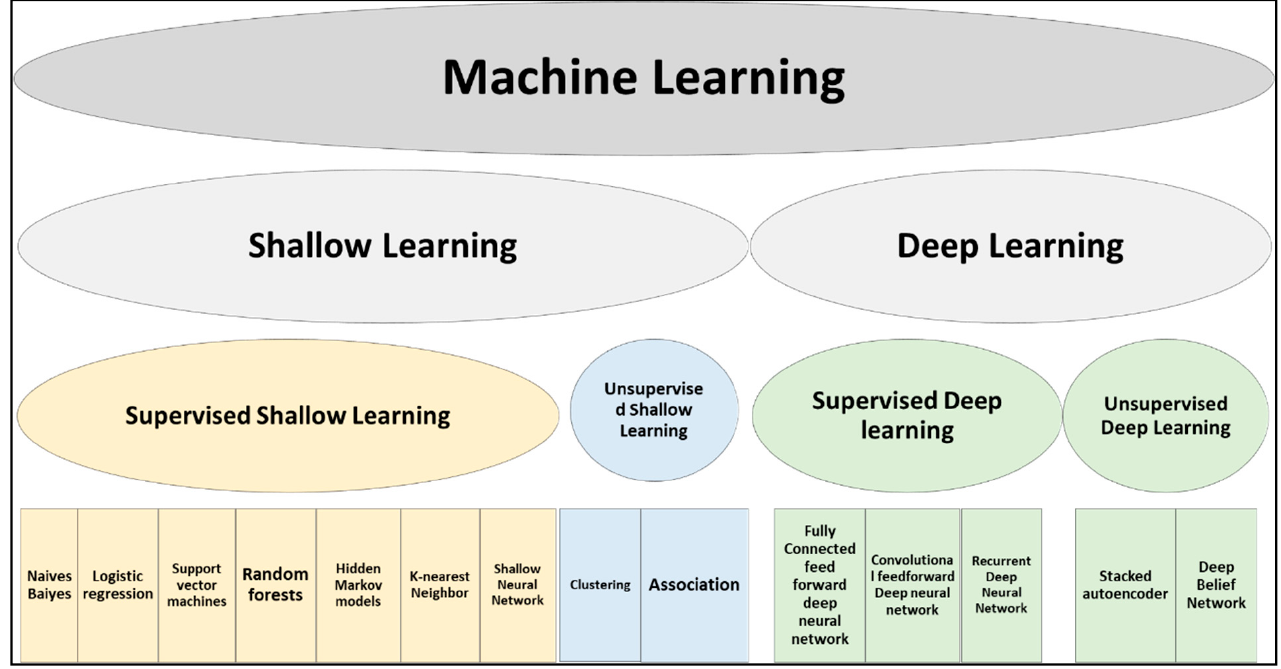
Figure 4. Classification of common machine learning algorithms used in energy systems.